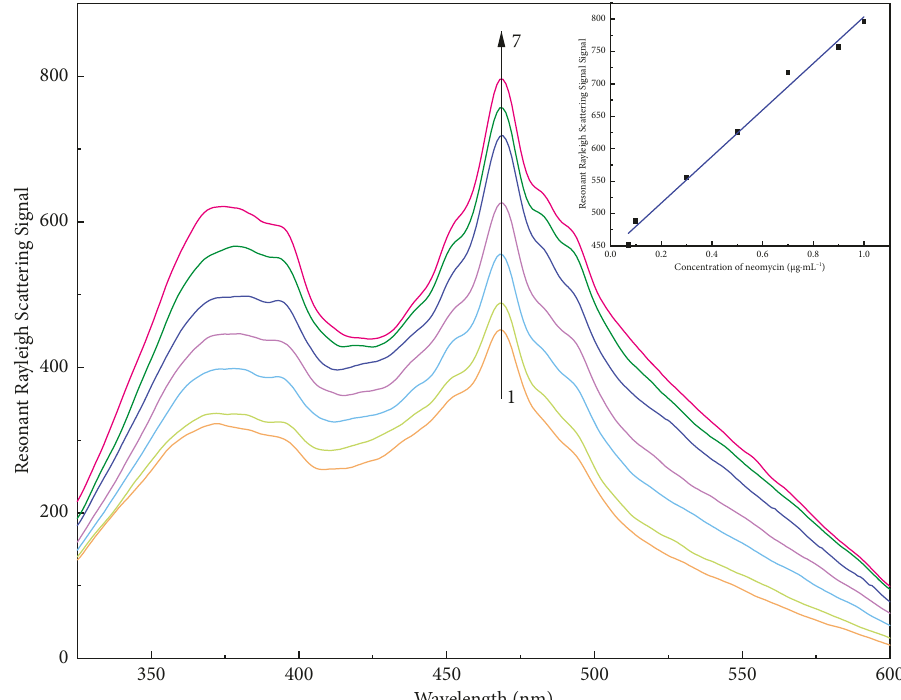
Figure 3: Resonance Rayleigh scattering spectra of congo red-neomycin-DTAB system.1–7:1mL pH 6.0 Britton–Robinson buffer solution, congo red:1.5